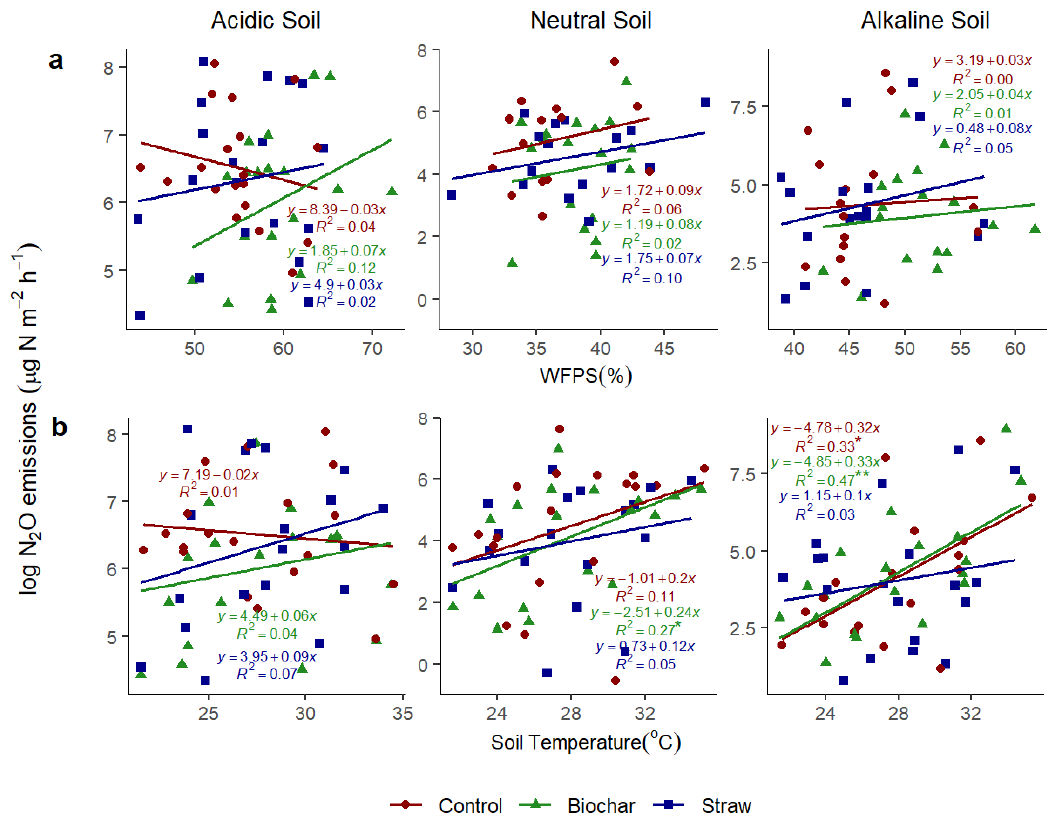
Figure 6. The relationships between N 2 O emissions and ( a ) soil water-filled pore space and ( b ) soil temperature in soils with different pH treated with biochar and straw, averaged over 19 days. Note: (*) shows that the strength of the relationship is significant at p -value ≤ 0.05, (**) shows that the strength of the relationship is significant at p -value ≤ 0.01. The axes of the different natural soil pH values are on different scales, and the log designation refers to natural logarithms.